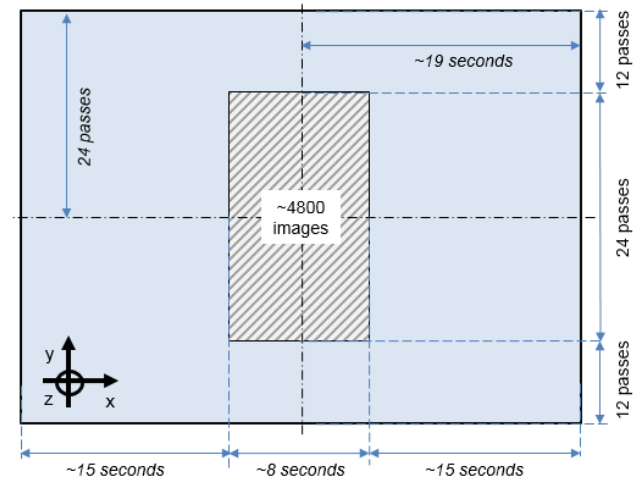
Figure 8. Schematic representation of a workpiece layer with the approximate duration of a tool pass (in seconds) and the total number of tool passes per layer. The shade depicts the area where the force values are chosen for